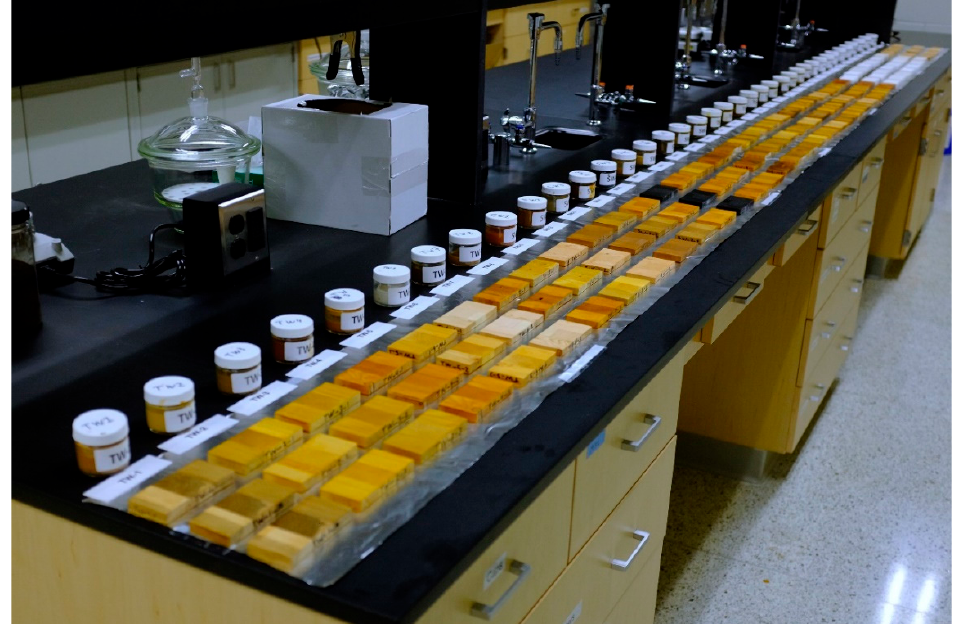
Figure 5. Image of coated small cross-laminated timber (CLT) samples.